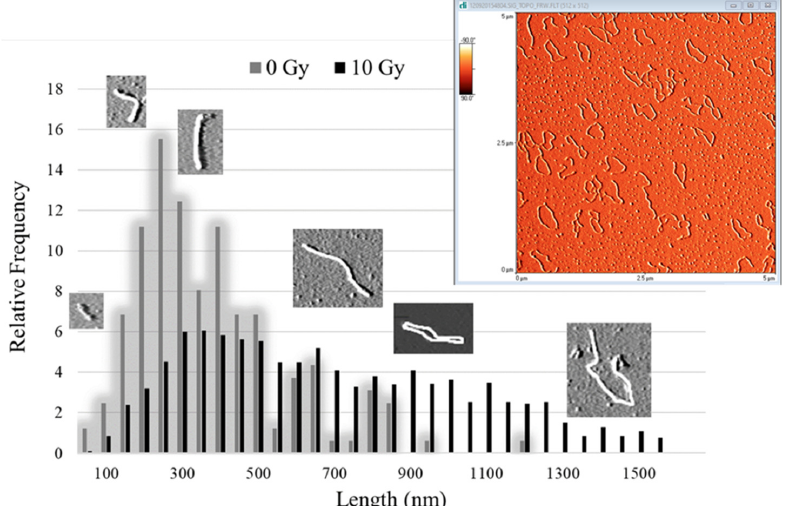
Figure 6. Atomic Force Microscopy (AFM) measurements: The relative frequency distribution of apparent molecule lengths for control sample (0 Gy) and irradiated with 10 Gy (proton beams) together with AFM images of DNA molecules of different forms. A representative AFM image (5 µ m × 5 µ m) of plasmid pBR322 on freshly cleaved mica surface, revealing the DNA macromolecule conformations. Such images are used as input for length evaluation and spread-out full-length circular molecules are utilized as calibration rulers for pixel-to-nm conversion. The length of the super-twisted supercoiled fraction is underestimated due to its adsorption on the mica surface. As a result, the apparent length of control plasmid is recorded smaller, while plasmid irradiated with plasmid is distributed along the whole range of lengths.